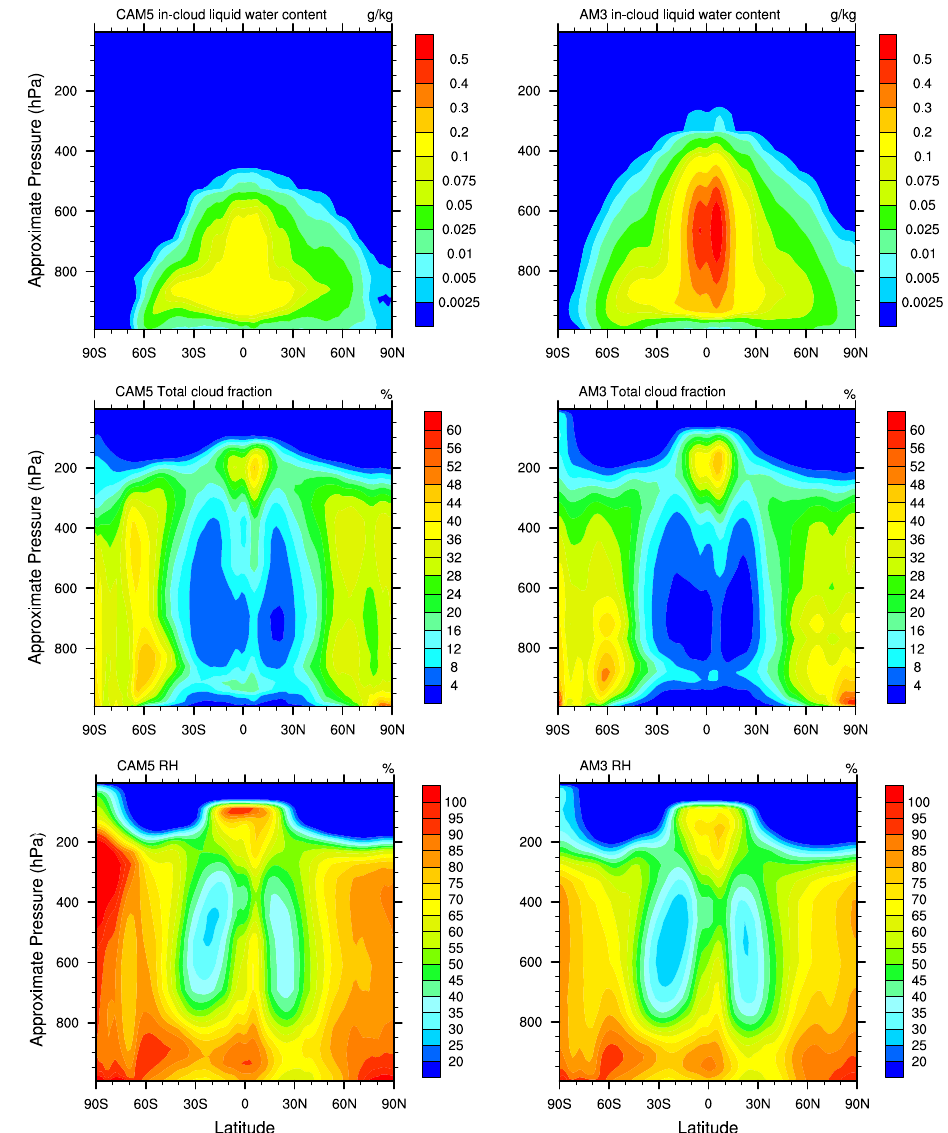
Fig. 4. Annual zonal mean in-cloud liquid water content (top), total cloud fraction (middle) and relative humidity(bottom) from CAM5 (left) and AM3